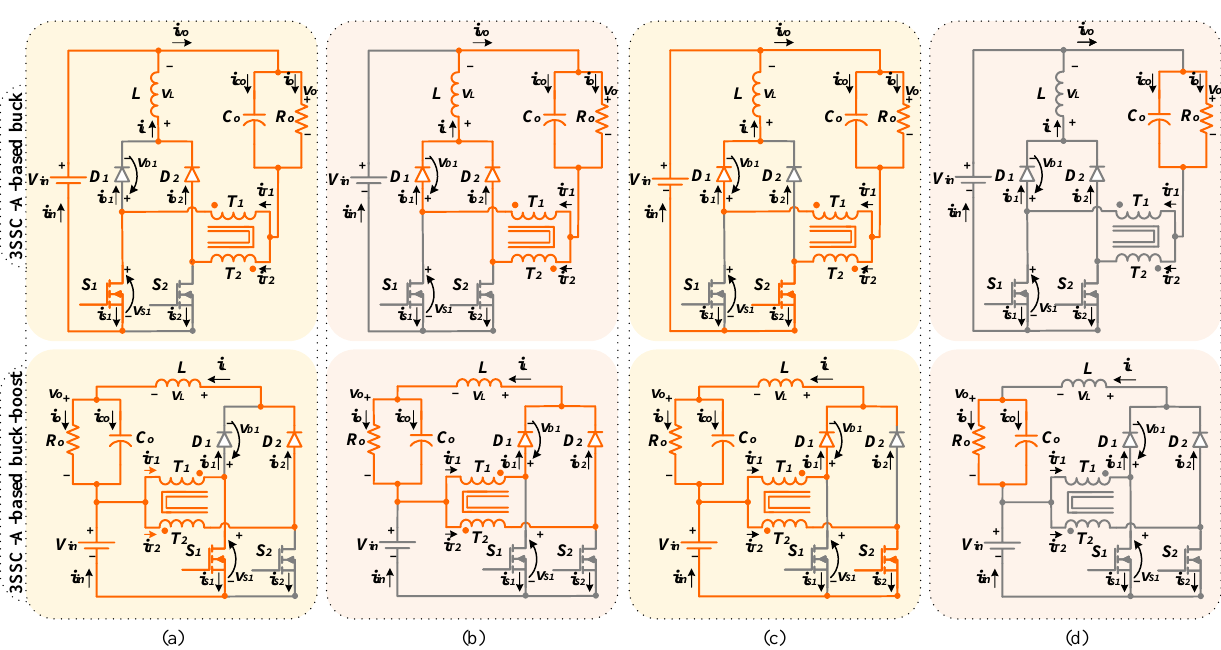
Figure 1. Operation stages of 3SSC-A-based step-down converters: ( a ) First stage. ( b ) Second stage. ( c ) Third stage. ( d ) MDC